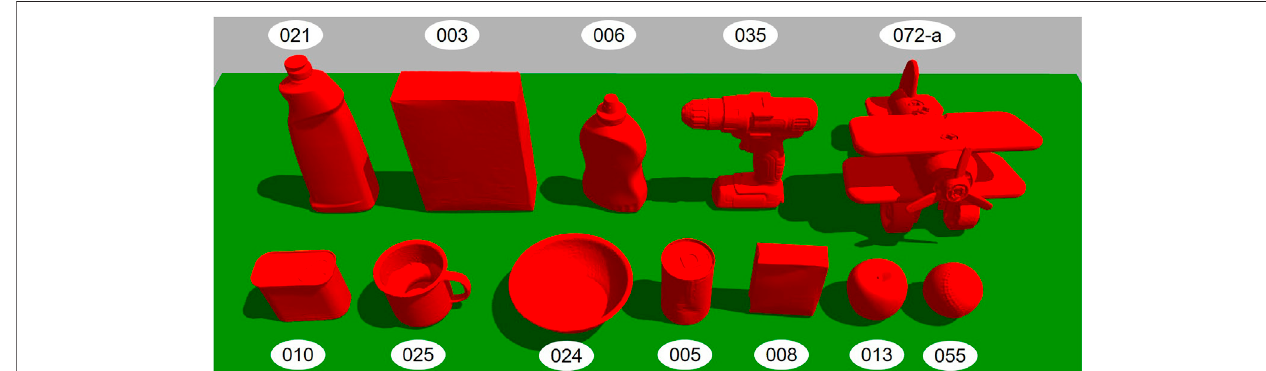
FIGURE 9 | The set of objects used for simulation testing. Each object is labeled with its YCB ID.